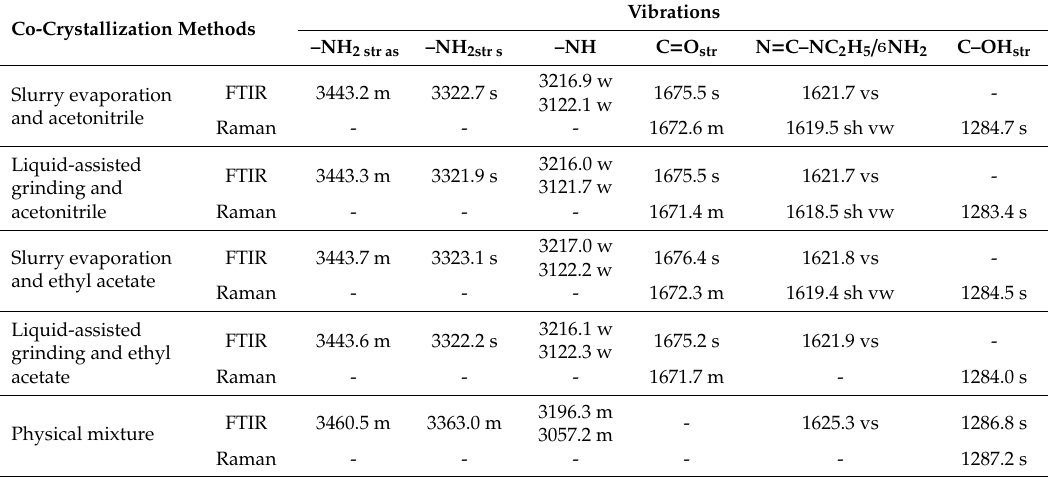
Table 5. Characteristic FTIR and Raman bands of chlordiazepoxide co-crystals with p -aminobenzoic acid, prepared using different co-crystallization methods and solvents.